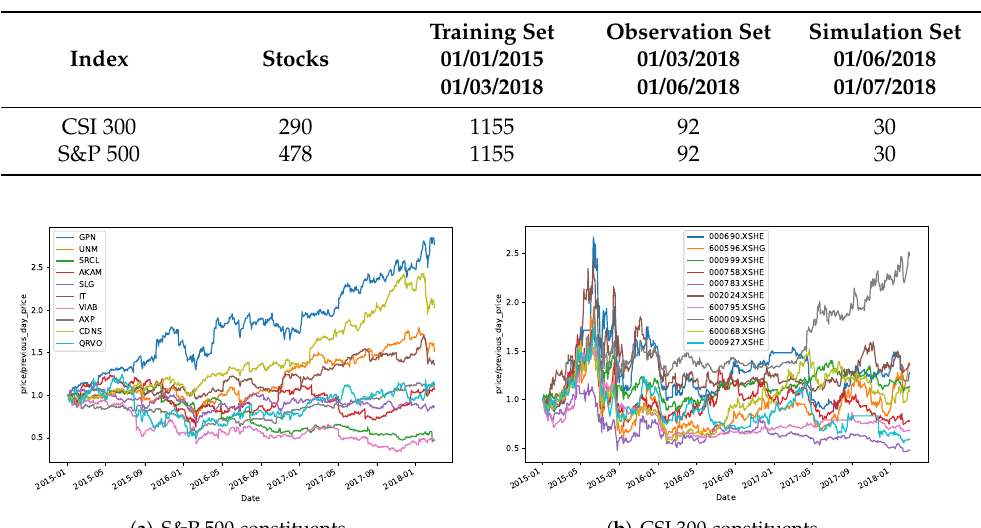
Table 1. Statistics of research data.